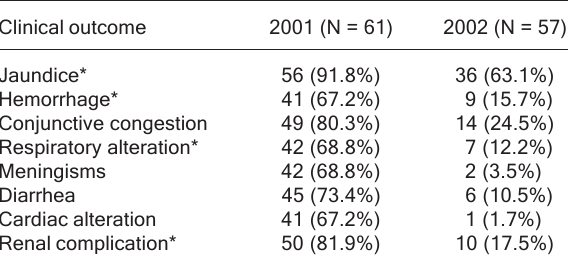
Table 1. Clinical outcome of leptospirosis patients who had been infected during 2001 or 2002.